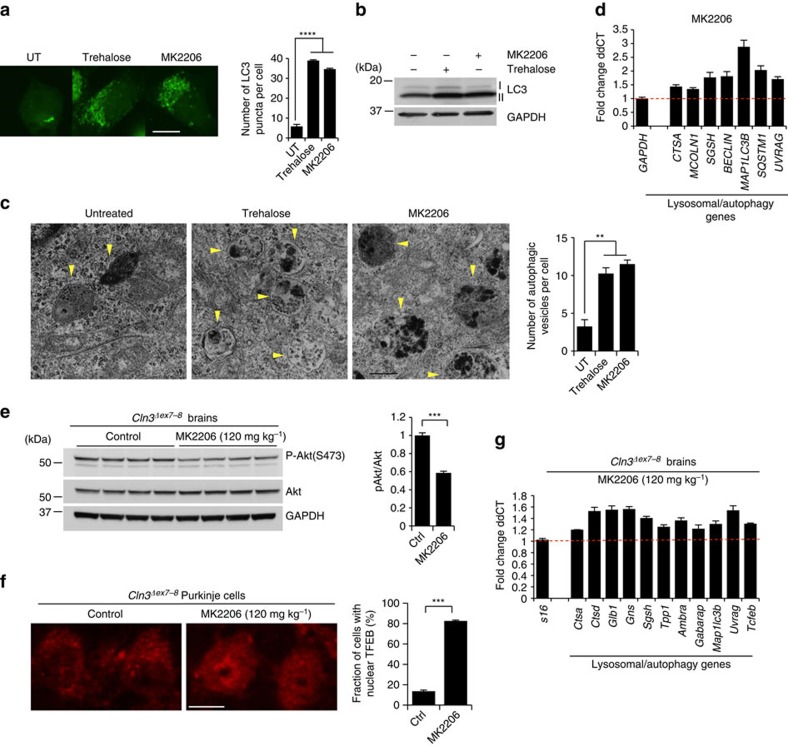
Akt inhibition promotes TFEB nuclear translocation and activation of the CLEAR network.(a) LC3 staining showing increased number of puncta in cells treated with trehalose or MK2206. (b) Immunoblot analysis of LC3 lipidation. (c) Micrographs of HeLa cells showing increased number of autophagic vesicles (yellow arrows) in samples treated with trehalose or MK2206. (d) Expression analysis of lysosomal and autophagy genes in HeLa cells treated with MK2206. Gene expression was normalized relative to the housekeeping gene, GAPDH. The dashed line indicates relative gene expression in untreated cells. (e–g) Intraperitoneal injection of MK2206 in Cln3Δex7-8 mice shows inactivation of Akt (e), nuclear translocation of TFEB (f) and upregulation of lysosomal and autophagy genes (g). Scale bar, 10 μm (a), 50 nm (c) and 20 μm (f).